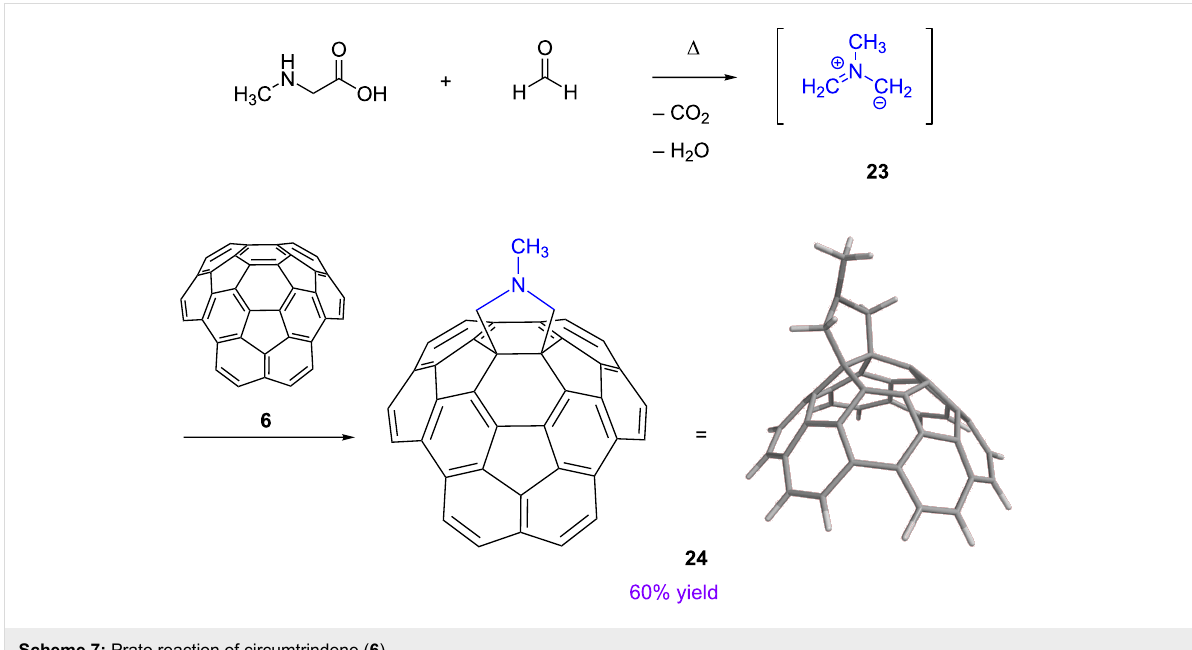
Scheme 7: Prato reaction of circumtrindene ( 6 ).